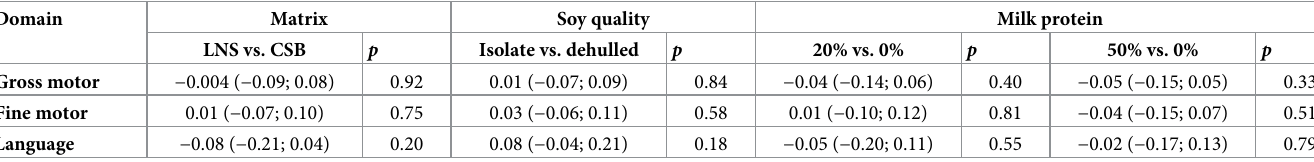
Table 4. Effects of supplementary foods on MDAT z-scores after intervention (24 weeks, n = 1,503).